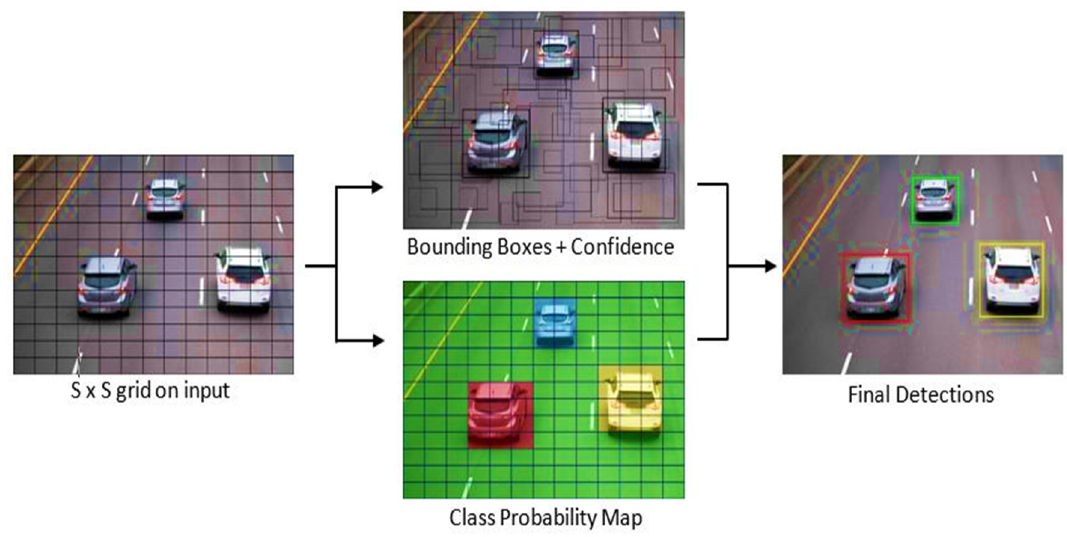
Figure 4. The framework of the YOLO